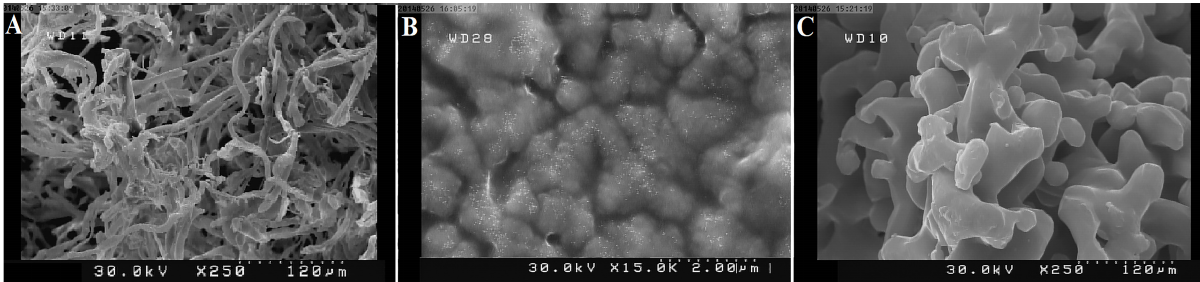
Figure 3 - SEM analysis of LDM (A), LPM (B), and Deflux particles (C) before